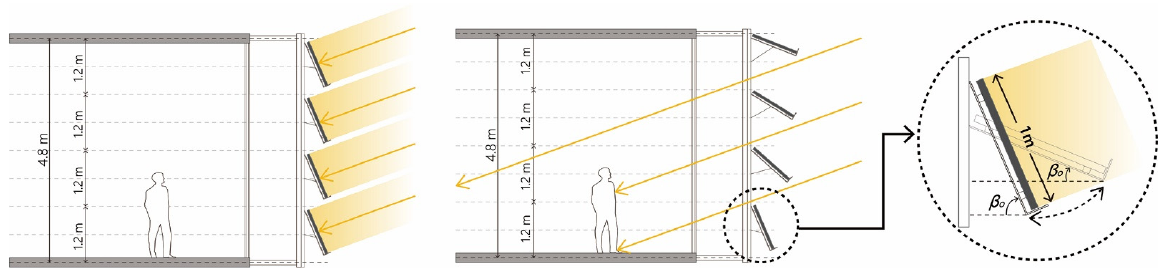
Figure 4. Principle of solar panel facade system and optimal tilt angle ( βо ).